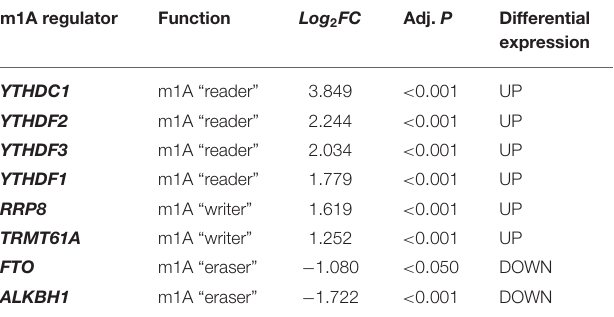
TABLE 2 | Identification of 8 AAA-related m1A regulators.